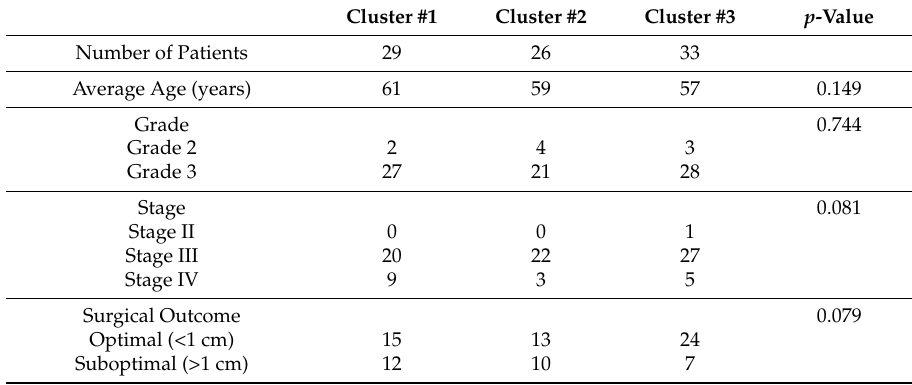
Table 1. Clinical characteristics of 88 non-responder HSGC patients. Non-responders ‡ were divided by their resulting clusters after the iClusterPlus analysis. All of the clinical characteristics were not statistically different between the resulting